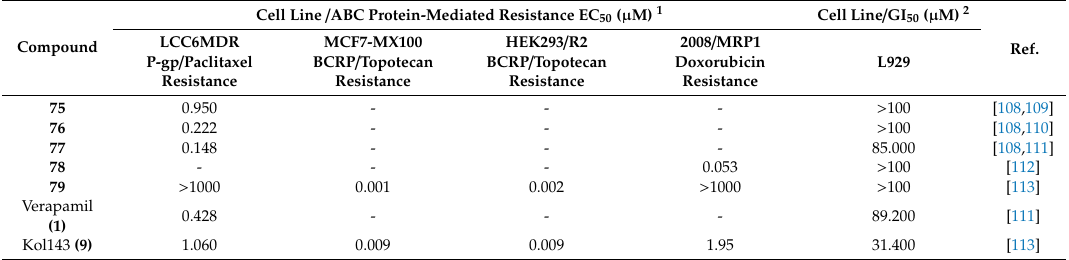
against LCC6MDR cells by 50%. Lower EC 50 values mean stronger MDR reversal properties; 2 —GI 50 - Defined as the concentration of compound that inhibits cell growth by 50%.